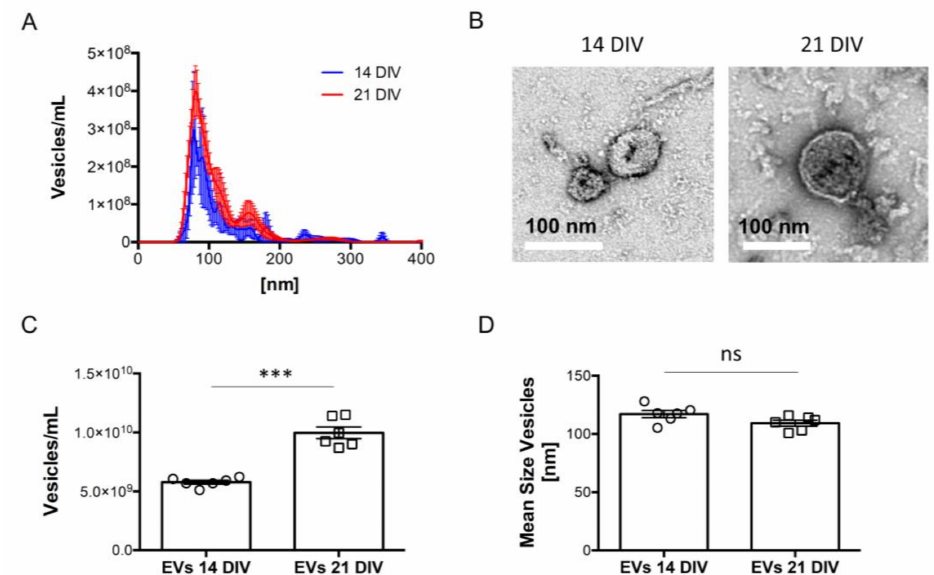
Figure 1. Characterization of extracellular vesicles (EVs) isolated from 14 and 21 DIV rat cortical neural cultures. EVs samples from neuronal culture media were processed by serial centrifugation, as described in “Materials and Methods”. ( A ) Plot showing the size distribution of EVs secreted by 14 and 21 DIV rat cortical neural cultures and quantified in the post-10,000 g supernatant through Nanoparticle tracking analysis with the help of a NanoSight NS500 instrument. ( B ) Representative Transmission Electron Microscopy (TEM) images of EVs isolated from the media of 14 and 21 DIV neural cultures using the protocol shown in “Materials and Methods”. Scale bars on both images represent 100 nm. ( C ) Plot comparing the total number of EVs present in the media of 14 and 21 DIV neural cultures, determined from the area under the curve (AUC) of size distribution profiles like the ones shown in panel A. Data are expressed as vesicles/mL, and the bars represent mean ± SEM. Statistical significance was analyzed by two-tailed unpaired t -test (*** p < 0.001, n = 6). ( D ) Plot comparing the size of EVs present in the media of 14 and 21 DIV neural cultures, determined from size distribution profiles as the ones shown in panel A. Data are expressed as the mean size of vesicles, and the bars represent mean ± SEM. Statistical significance was analyzed by a two-tailed unpaired t -test (ns = non-significant, n =